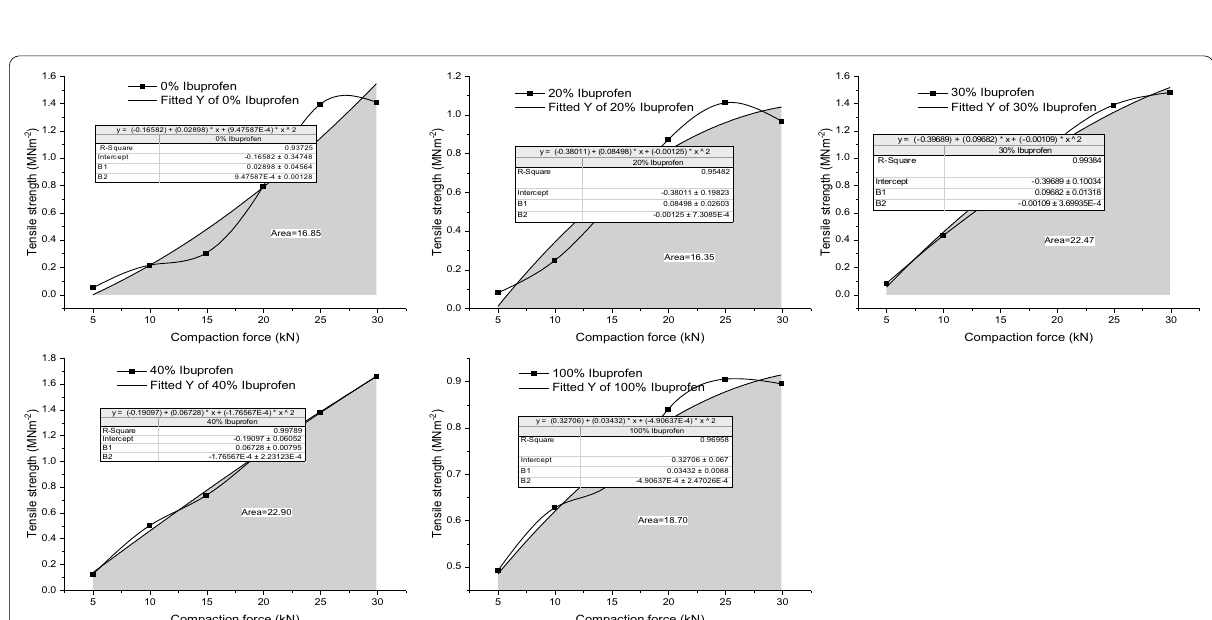
Fig. 5 Area under the tensile strength–compaction force curve for StarLac ® . Tensile strength computed according to the Podczeck et al. (2013)